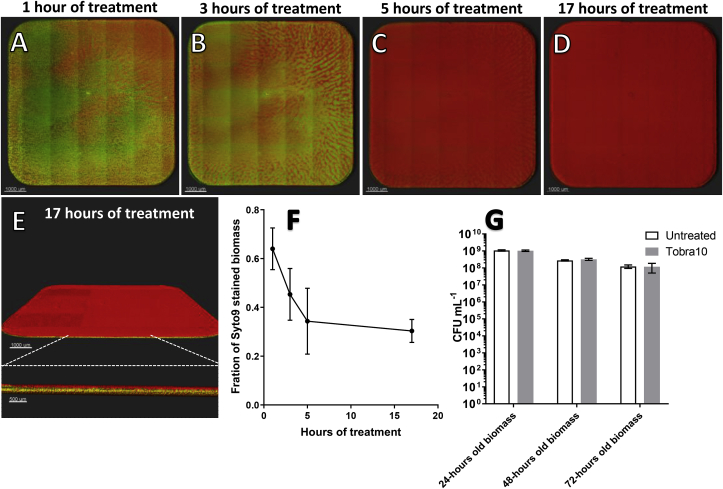
3D projections of 24-h old biomass treated with 10 μg mL−1 tobramycin and stained with live/dead stains. A) The biofilm 1 h after the beginning of treatment. B) The biofilm 3 h after the beginning of treatment. C) The biofilm 5 h after the beginning of treatment. D) The biofilm 17 h after the beginning of treatment. E) Side view of 17-h old treated biofilm, also shown in 5D. Zoom showing the top layer of PI-stained biomass on top of Syto9-stained biomass. F) Fraction of biomass stained green with Syto9. Biomass of both PI- and Syto9-stained cells were quantified, and the part stained with Syto9 was taken as a fraction of the total. G) CFU after 17 h of Tobramycin (10 μg mL−1) treatment or untreated biomass in microtiter wells grown 24, 48, or 72 h before treatment. (For interpretation of the references to color in this figure legend, the reader is referred to the Web version of this article.)